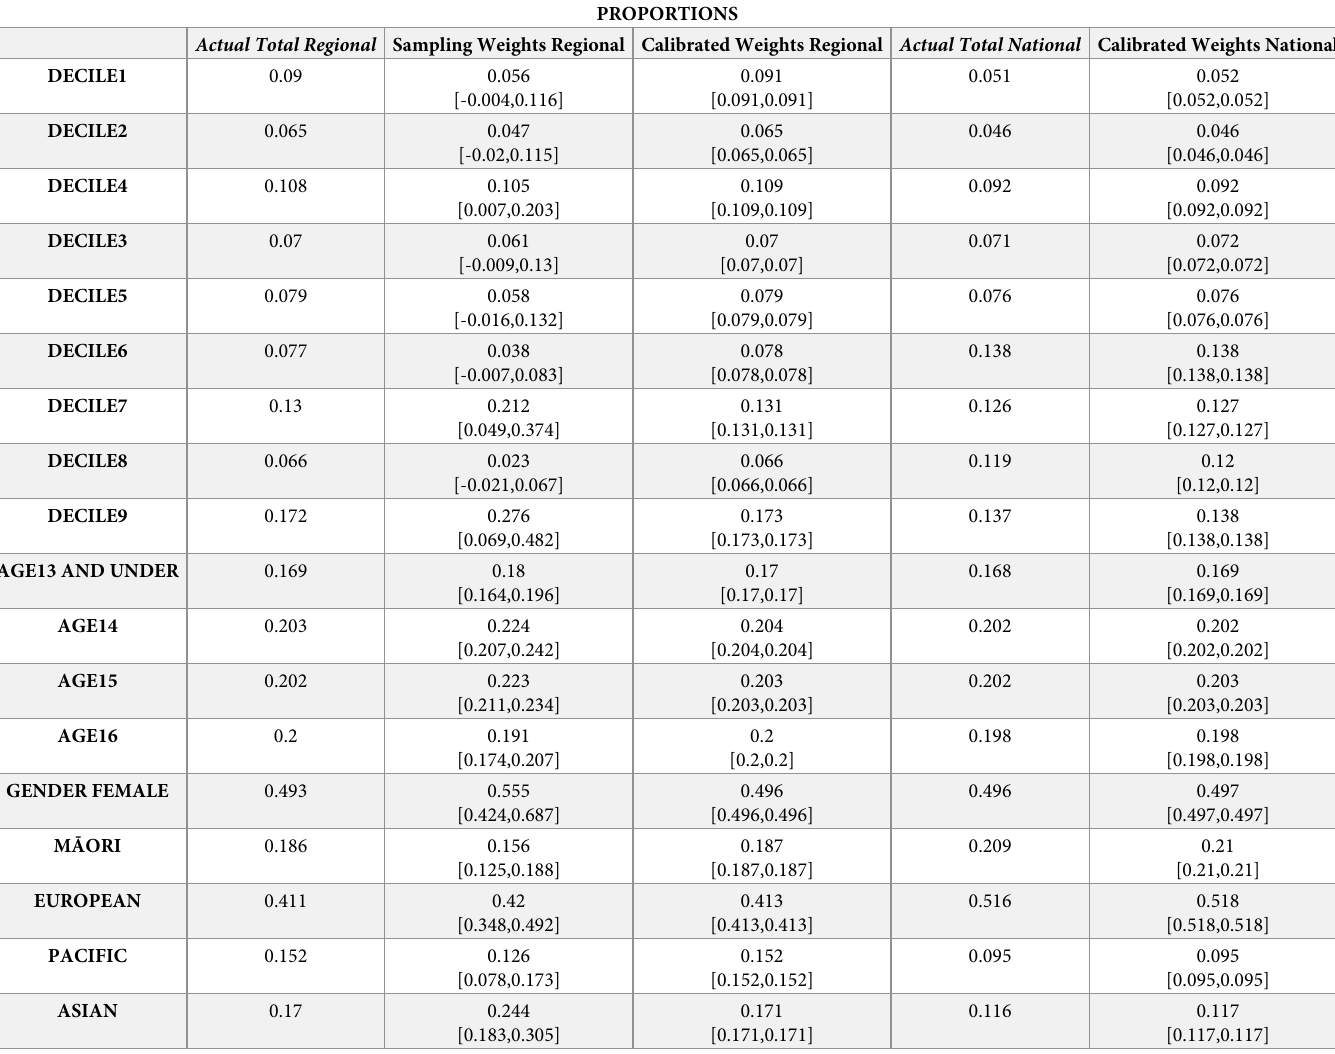
Table 4. National and regional estimates- comparison of actual quantities, estimates using sampling weights and estimates using calibrated weights.